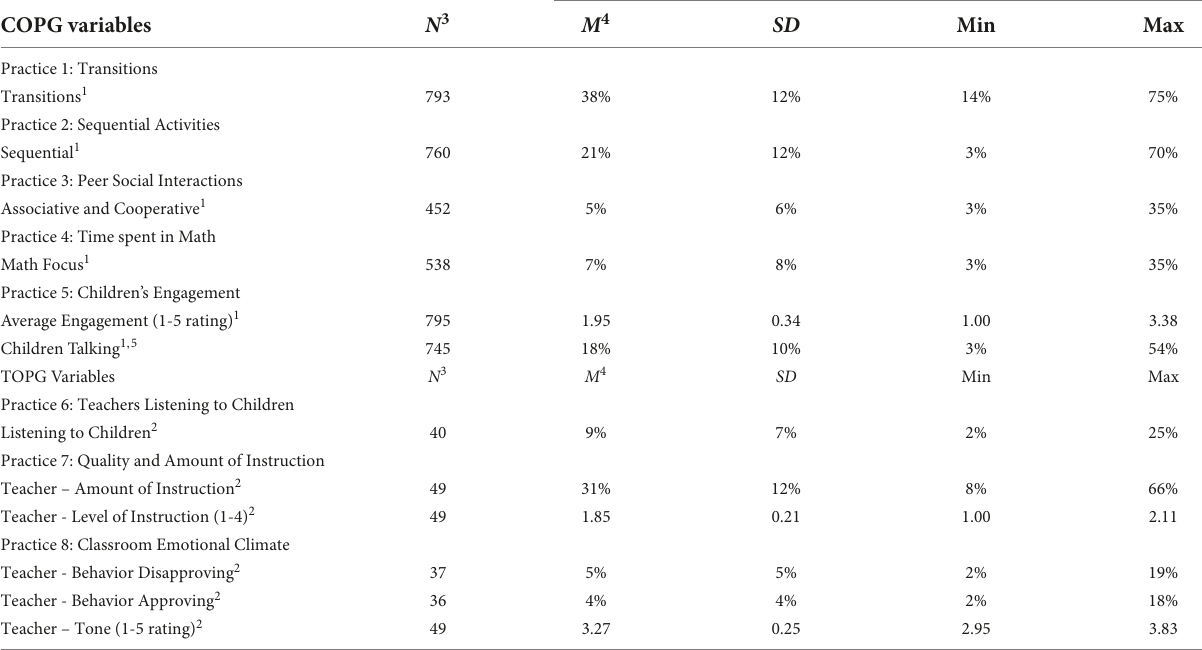
TABLE 1 Descriptive information on key classroom practices